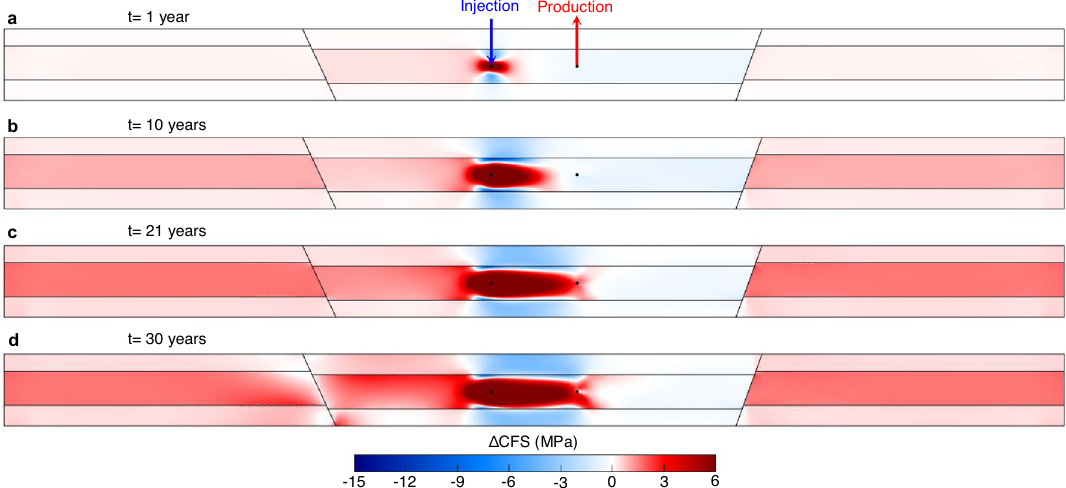
Figure 4. Fault reactivation potential of planes with the same orientation as fault 1. Distribution of the Coulomb Failure Stress changes (ΔCFS) in the direction of fault 1 after 1 ( a ), 10 ( b ), 21 ( c , corresponding to fault 1 reactivation) and 30 ( d ) years of cold water reinjection. Negative values of ΔCFS imply improved stability while positive values show worsened